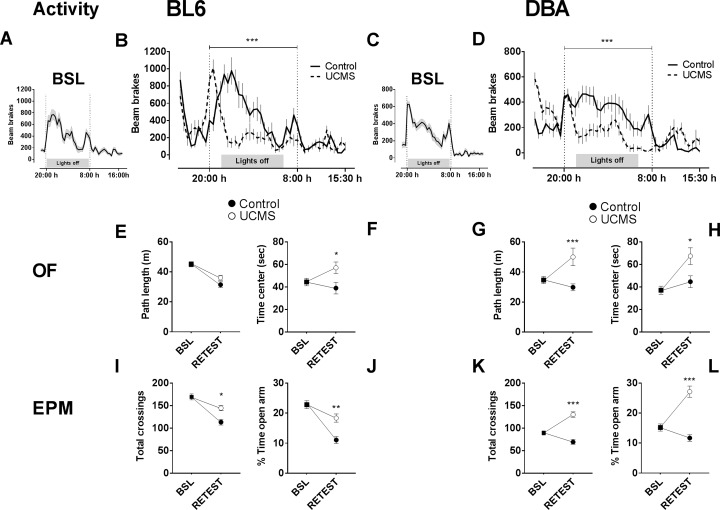
Effect of UCMS on overnight activity, exploratory and anxiety-like behavior.(A-D) In the overnight activity test, at baseline testing BL6 mice (A) were more active than DBA mice (C), but showed similar activity patterns. Groups exposed to UCMS (C, D) showed decreased overnight activity. In the open-field test, (E) BL6 mice exposed to UCMS (white circles) do not differ from CTRLS (black circles) on path length. (G) DBA exposed to UCMS showed increased distance travelled. (F) UCMS-exposed BL6 mice and (H) UCMS-exposed DBA mice spent significantly more time in the center. In the elevated plus maze, total number of arm entries were recorded as well as time spent in the open arms. (I, J) BL6 mice exposed to UCMS and (K, L) UCMS-exposed DBA mice show increased beam crossings and time spent in the open arms. Values are expressed as mean +/- SEM. *, p < 0.05; ** p < 0.01; *** p < 0.001; UCMS vs. CTRL.